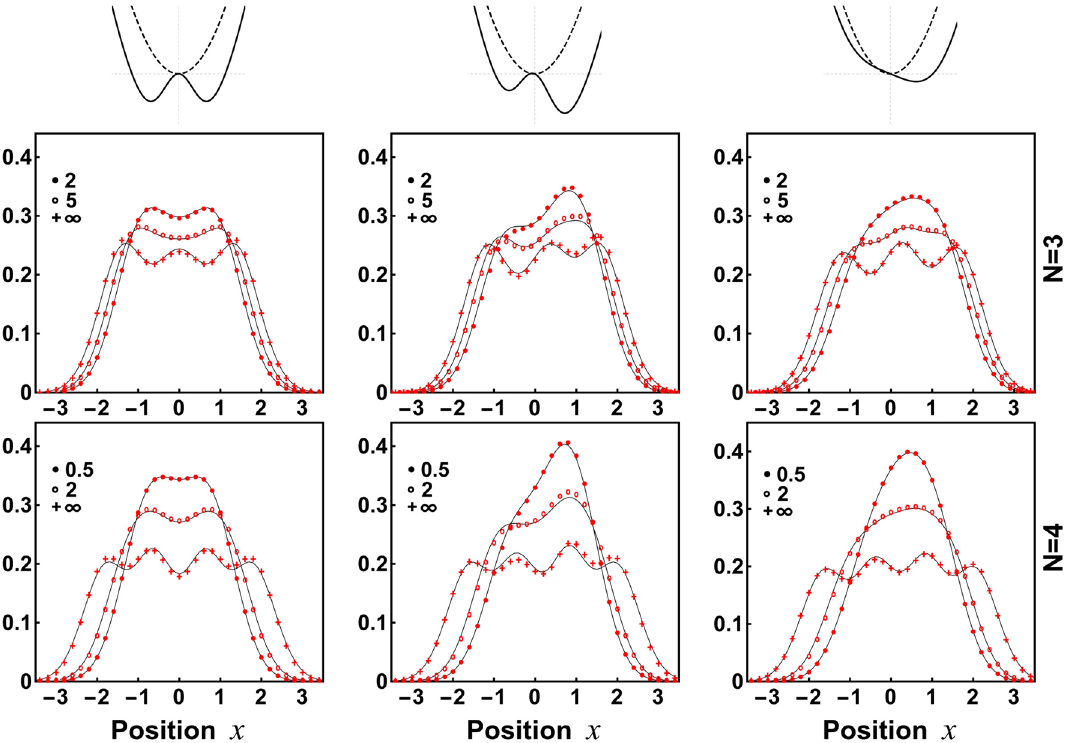
3 and N 4 bosons ρ( x , x ) for the system containing N = = = ( 1.0, 0.5, 0.0 ) , ( (cid:31) , δ , ξ) ( 1.0, 0.5, 0.2 ) , and ( (cid:31) , δ , ξ) ( 1.0, 1.0, 0.2 ) . = = =